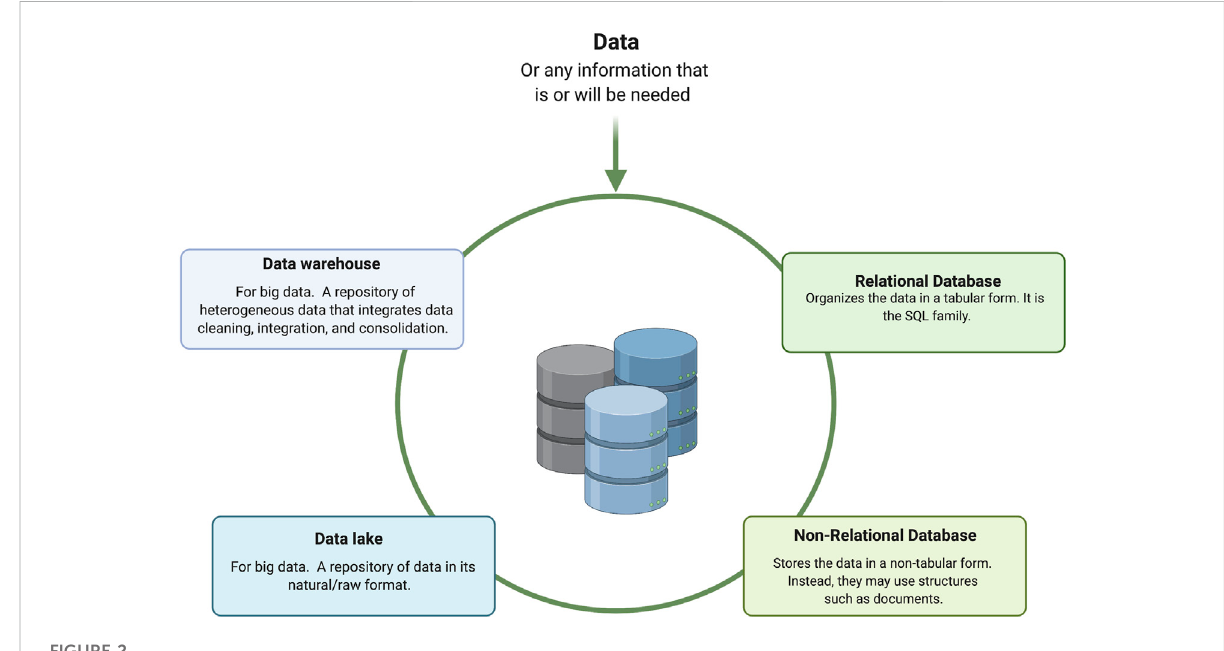
FIGURE 2 An overview of the most common data storage